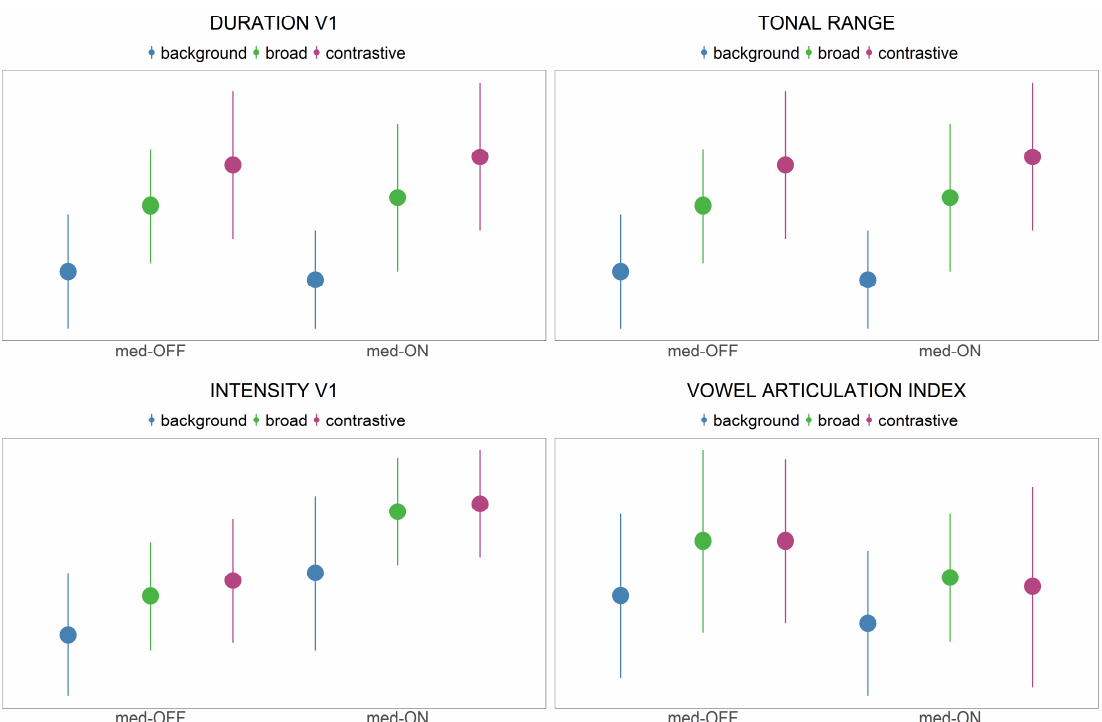
Figure 5. Presentation of z-transformed values (mean and sd) of acoustic measurements depending on medication condition and prominence condition. Table 3. Means and standard deviations for acoustic parameters of interest depending on promi- nence condition and medication condition.